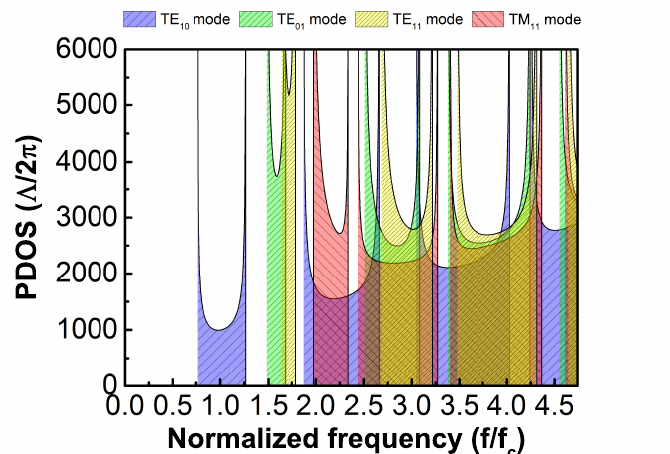
Figure 5. PDOS of TE 10 , TE 01 , TE 11 , and TM 11 modes for the quasi-1D PC with the dielectric constants ε 1 = 3.8, ε 2 = 1 and the thicknesses t 1 = 1.00 mm, t 2 = 3.30 mm, corresponding to a filling ratio of 23.26%. The combined PDOS of TE 10 , TE 01 , TE 11 , and TM 11 modes shows no photon states in some frequency